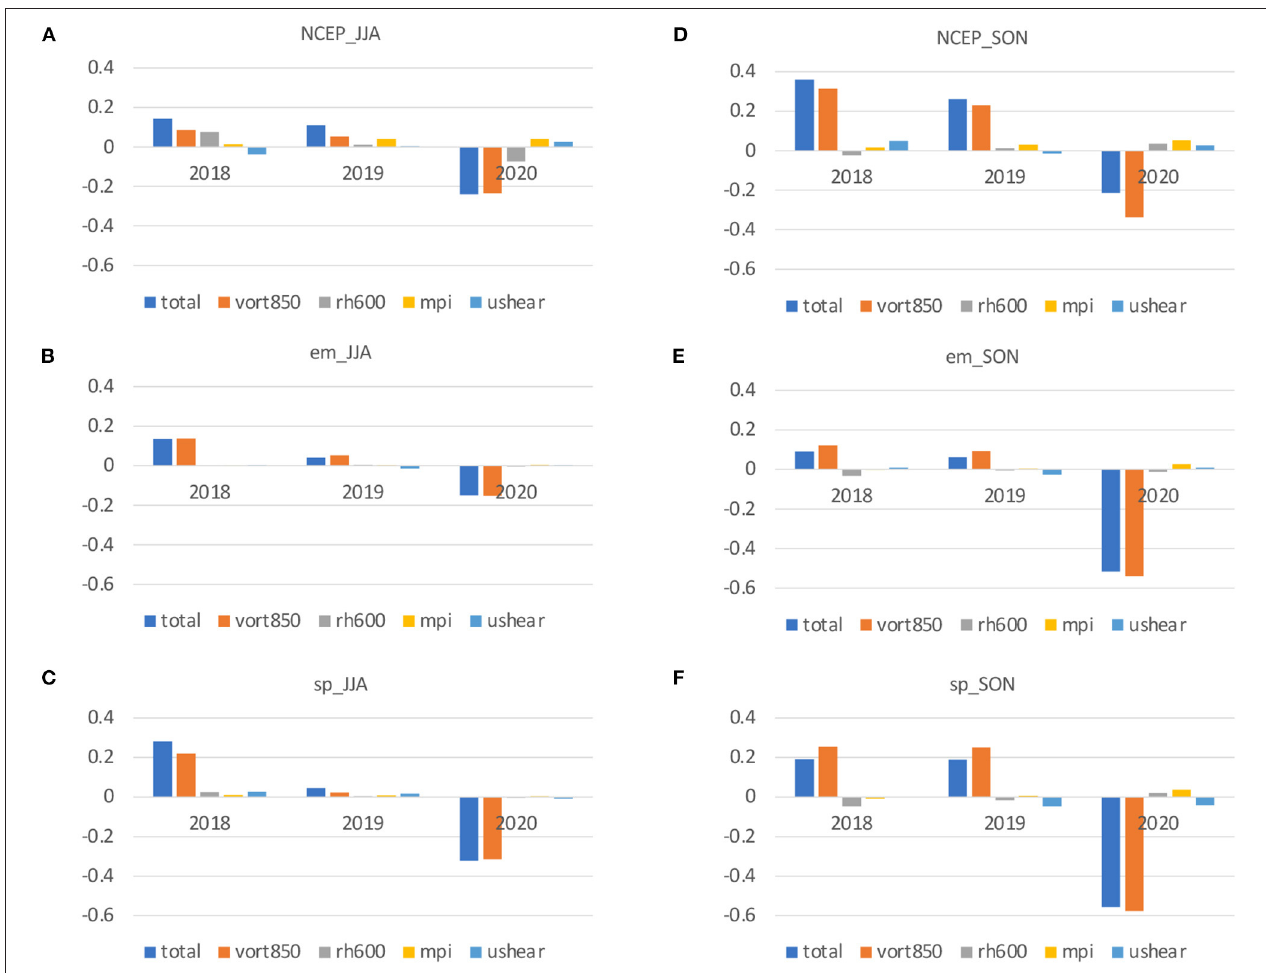
FIGURE 7 | Decomposed GPI contribution in each environmental variable during JJA (left) and SON (right) over the WNP (averaged over 5.20.N, 120.180.E). Total (blue bars), vorticity (orange), humidity (gray), MPI (yellow), and wind shear (aqua) contributions are shown. (A,D) is observation (NCEP reanalysis), (B,E) is the Emanuel scheme AFES, and (C,F) is the spectral scheme